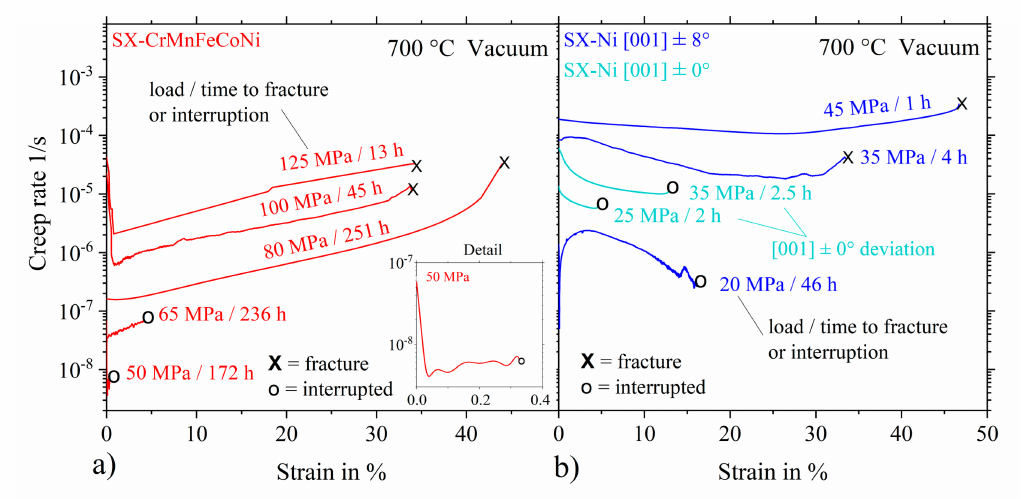
Figure 2. Creep rate over strain diagram for vacuum creep tests at 700 ◦ C of the single crystalline ( a ) CrMnFeCoNi alloy, and ( b ) pure nickel with a detail of the 50 MPa curve of the CrMnFeCoNi alloy in the